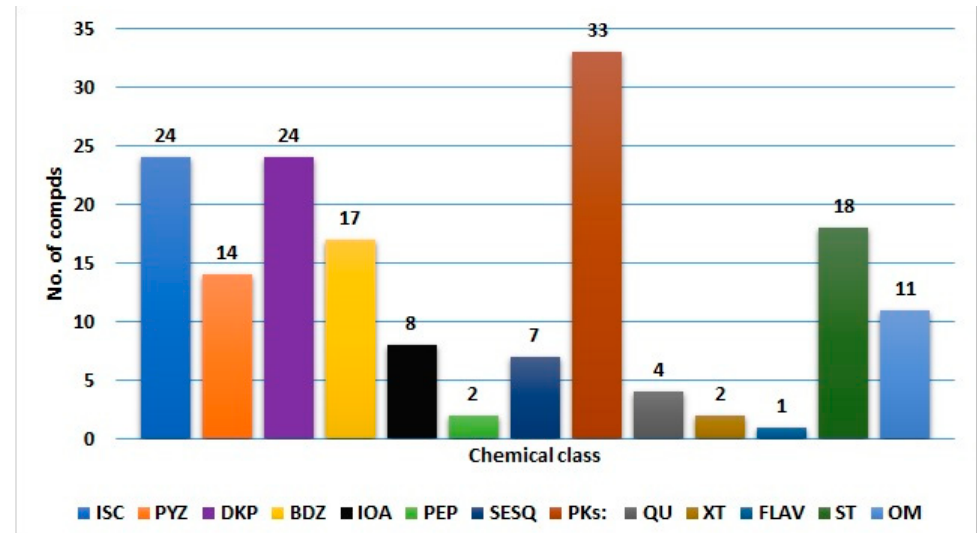
Figure 16. Different metabolites reported from A. ochraceus. ISC: Isocoumarins; PYZ: pyrazines; DKP: diketopiperazines; BDZ: benzodiazepine: IOA: indole and other alkaloids; PEP: peptides; SESQ: sesquiterpenoids; PKs: polyketides; QU: quinones; XT: xanthes; FLAV: flavonoids; ST: sterols; OM: other metabolites.